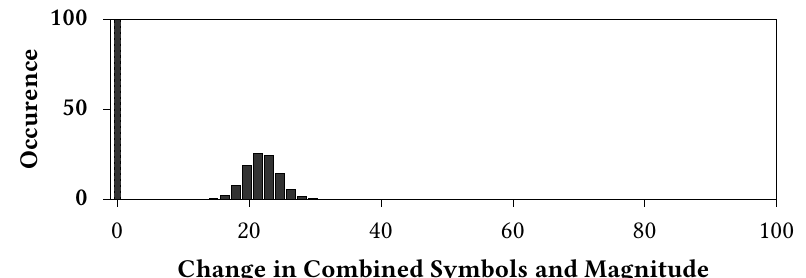
Figure 10: Uniqueness and Reliability according to Equation (33) and Equation (35) based on the evaluation of 115 covers of [ION + ] with 32 quantization intervals and a 10 × oversampling for the measurement.